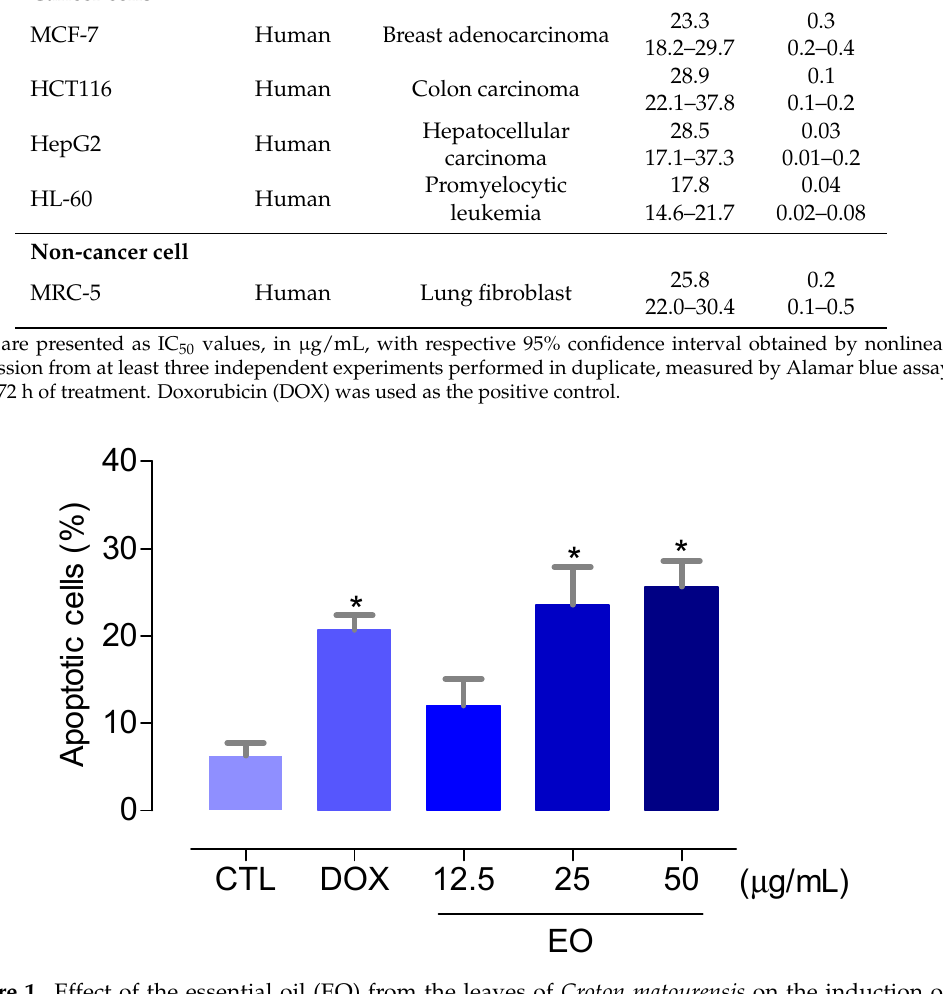
Figure 1. Effect of the essential oil (EO) from the leaves of Croton matourensis on the induction of apoptosis (early + late apoptotic cells) in HepG2 cells after 48 h of treatment, as determined by flow cytometry using annexin V-FITC/PI staining. The negative control (CTL) was treated with the vehicle (0.1% DMSO) used for diluting the EO. Doxorubicin (DOX, 1 µg/mL) was used as the positive control. Data are presented as the means ± SEM. of three independent experiments performed in duplicate. Ten thousand events were evaluated per experiment, and cellular debris was omitted from